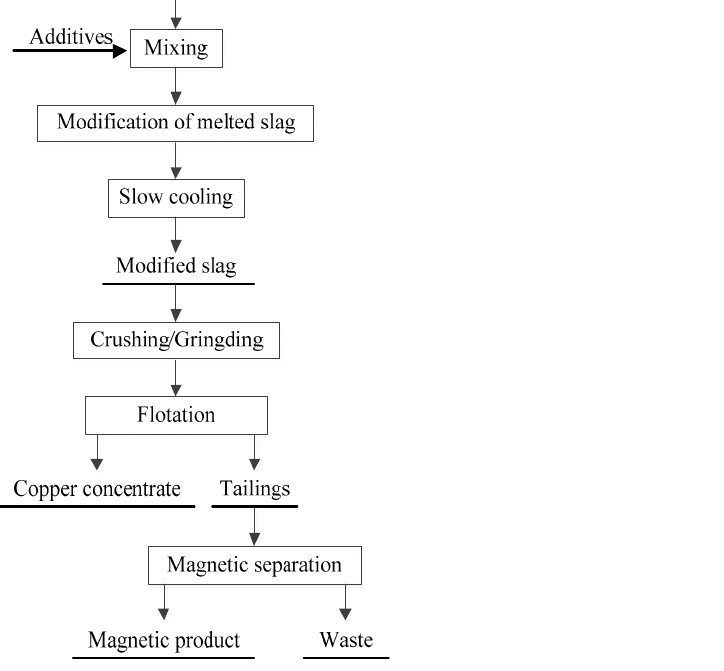
Figure 3. Schematic flow sheet of the modification ‐ beneficiation process of copper slag.